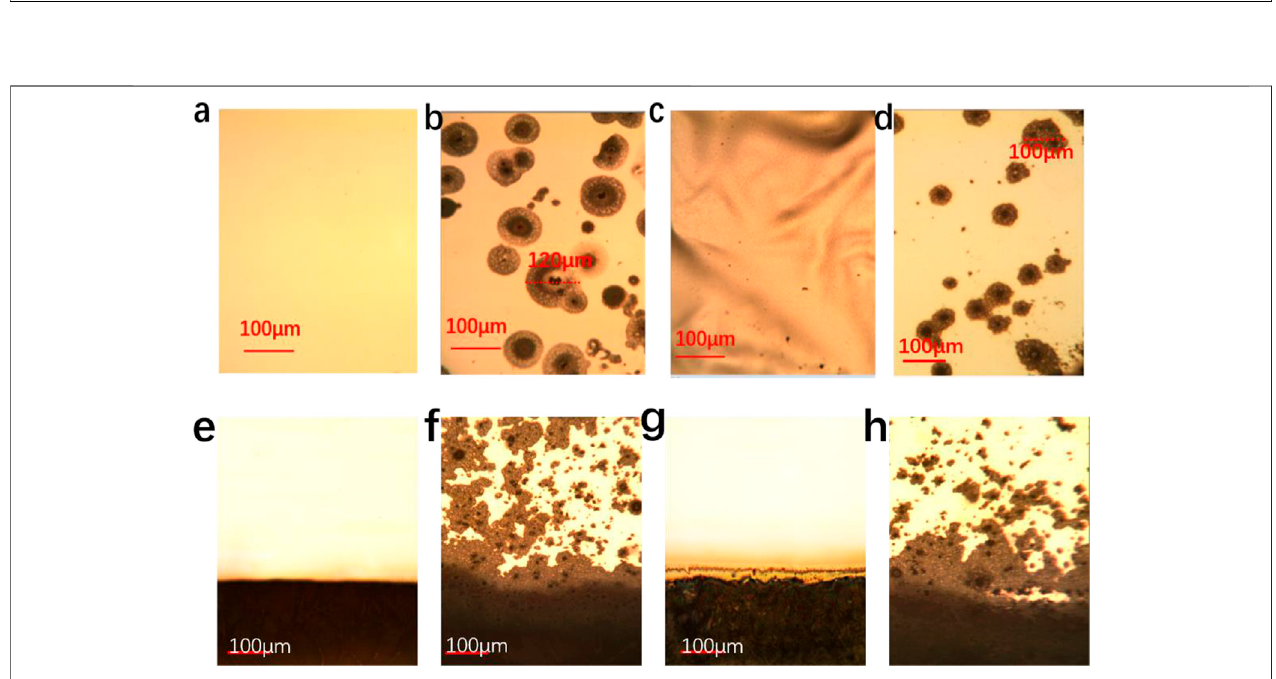
FIGURE3| EvolutionofphotovoltaicparametersofPSCs with different encapsulatedstructuresfor normalized PCEs (A) ,V 75% and room temperature. Encapsulated structures are EVA, paraf fi n and paraf fi n/EVA/paraf fi n fi lms, respectively.